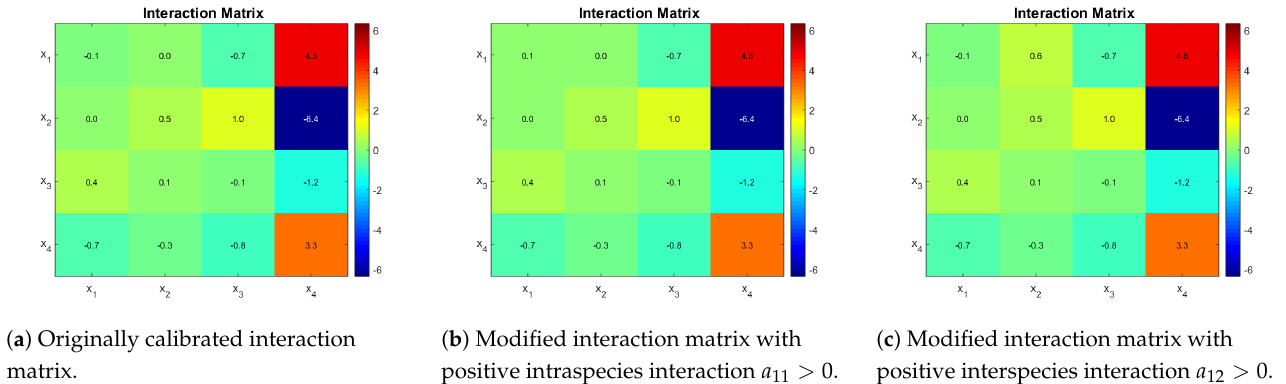
Figure 3. Interaction matrices for each case for a consortia of 4 bacterial species where x 1 and x 2 are AOB and x 3 and x 4 are NOB. Parameters a 11 and a 12 were modified in ( b , c ),